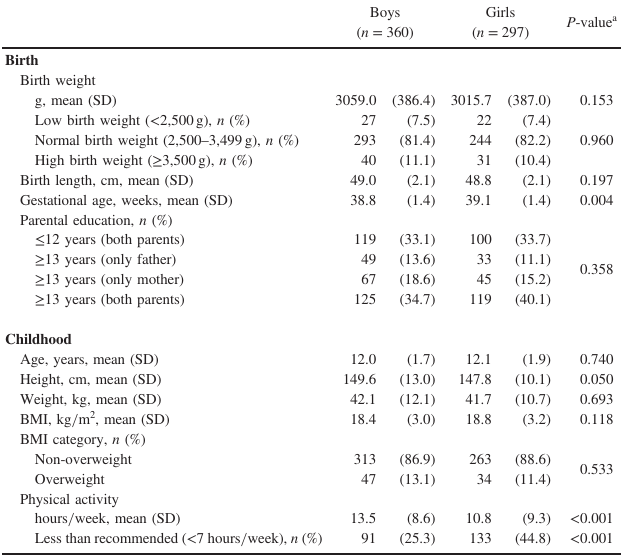
BMI, body mass index; SD, standard deviation. Data are means (SD) or number (percentage). a The t test for continuous and the χ 2 test for categorical variables.